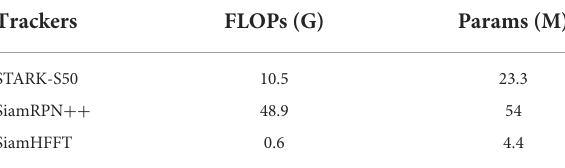
TABLE 4 Comparision about the FLOPs and params.